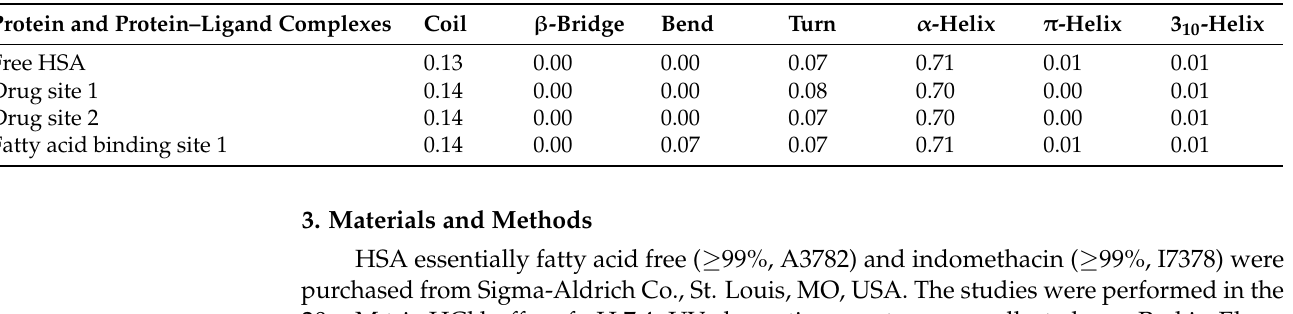
Table 8. Secondary structure composition of three sites of human serum albumin with indomethacin (source: gmx